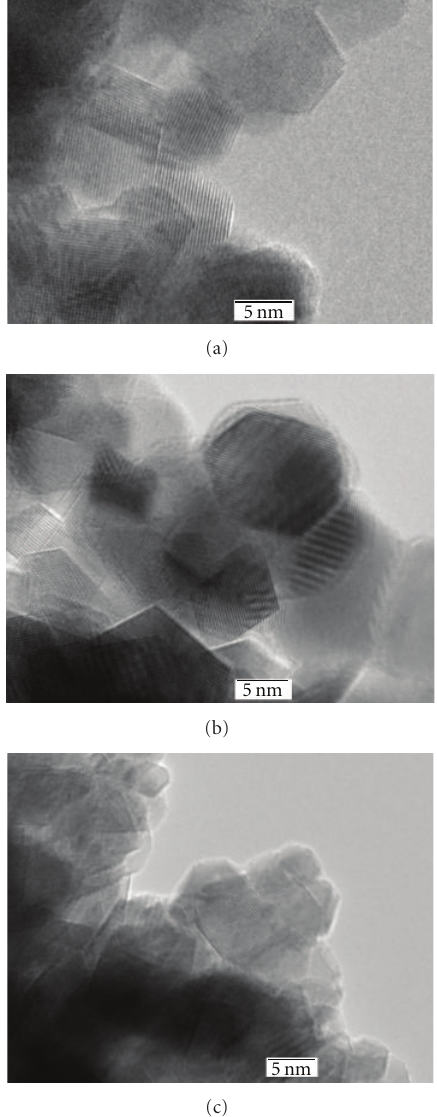
Figure 4: TEM images of sulfided catalysts. (a) RuPd, (b) RuRh, and (c) RhPd.